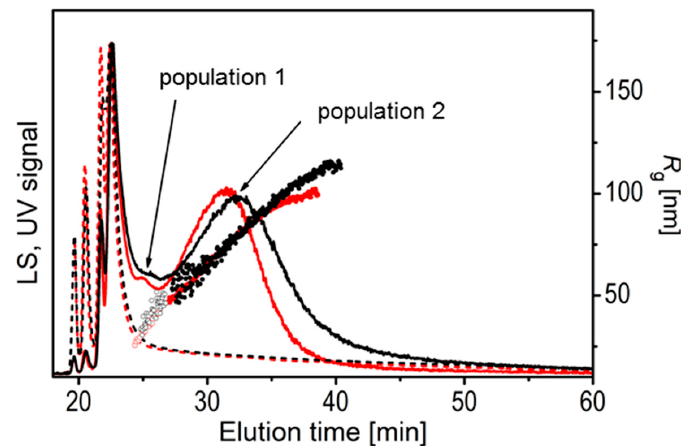
Figure 4. The AF4 / UV-MALS fractograms of unfiltered (black) and filtered (red) exosome standards (ES) together with radius of gyration R g as a function of time for smaller (open circles) and larger (full circles) vesicle populations. The solid lines represent the LS detector responses at 90° angle, while the dashed curves represent the UV detector responses.